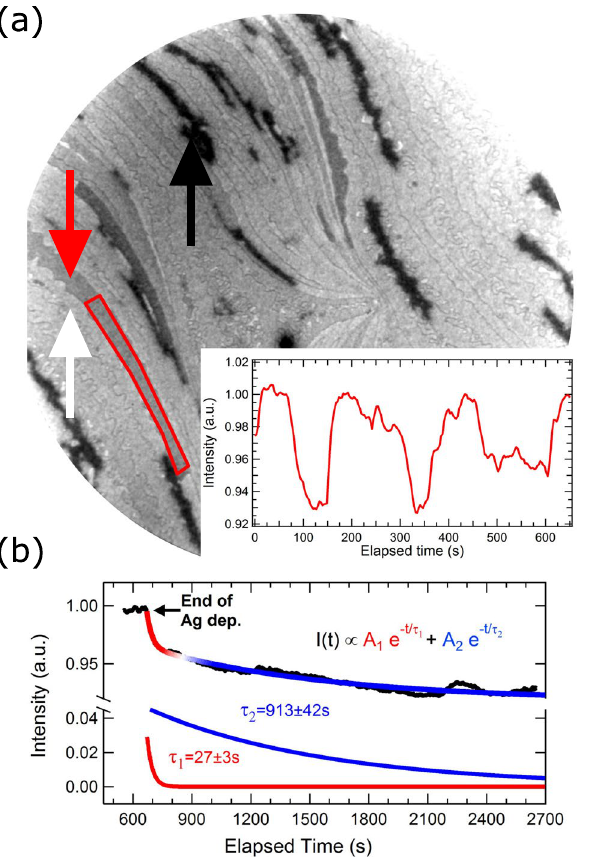
Figure 1. ( a ) LEEM image of a 3 -Ag surface during a Ag deposition at 243 K after the nucleation of 3D Ag islands (black areas, see black arrow) showing intensity inhomogeneities as illustrated by the intensity difference between the two neighbouring terraces indicated by the white and red arrows (electron energy, ε = 24 eV, field- of-view, FOV = 15 μ m). The inset illustrates the intensity time-evolution of the terrace highlighted in red in ( a ). ( b ) Time evolution of the LEEM image intensity averaged over the field-of-view (excluding 3D Ag islands) at the end of a Ag deposition at 220 K following the inhomogeneous regime ( ε = 24 eV). τ 1 and τ 2 are the parameters determined by a double exponential fit of the intensity variation (red-to-blue curve). The two exponential fits (arbitrary vertical shift) are shown (red and blue